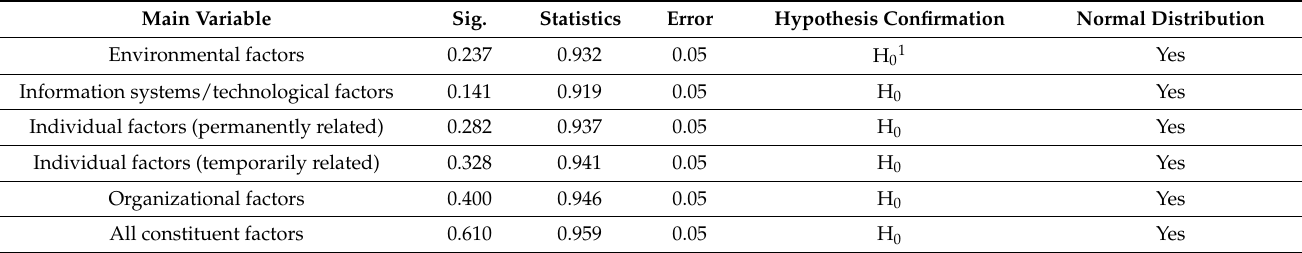
Table 3. Normality evaluation of research data using the Shapiro–Wilk test.